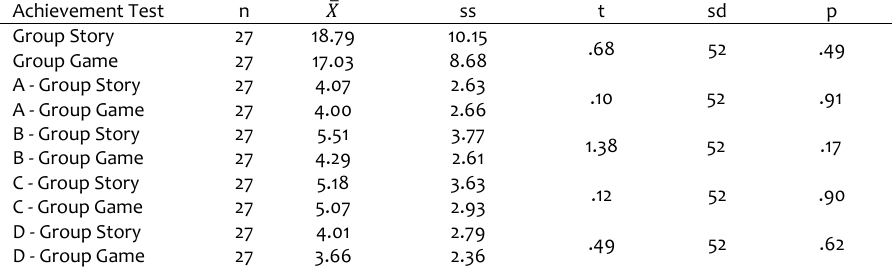
Table 3. The Independent Samples t-Test results regarding the pre-test scores of the Group Story and the Group